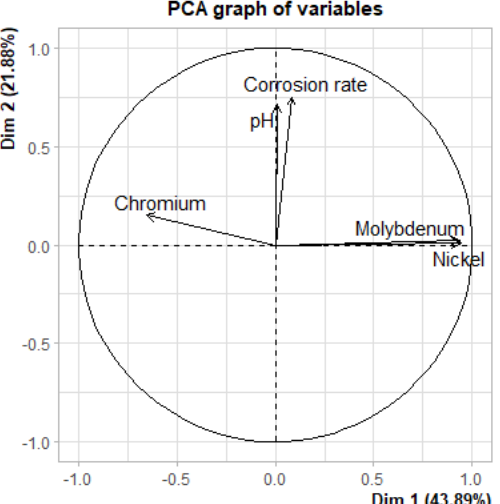
Figure 8. Biplot of the PCA − analysis to check the influence of alloying elements and the pH of the pore solution on the measured uniform corrosion rate.